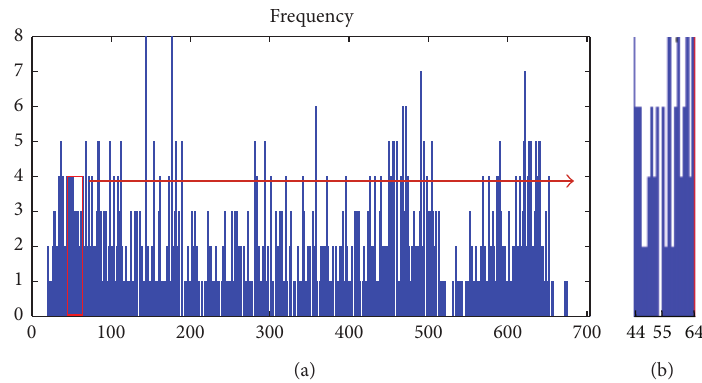
Figure 11: (a) The scatter gram of the frequency of the template samples in 𝑥 -axis. (b) Detail with enlarged scale of (a).